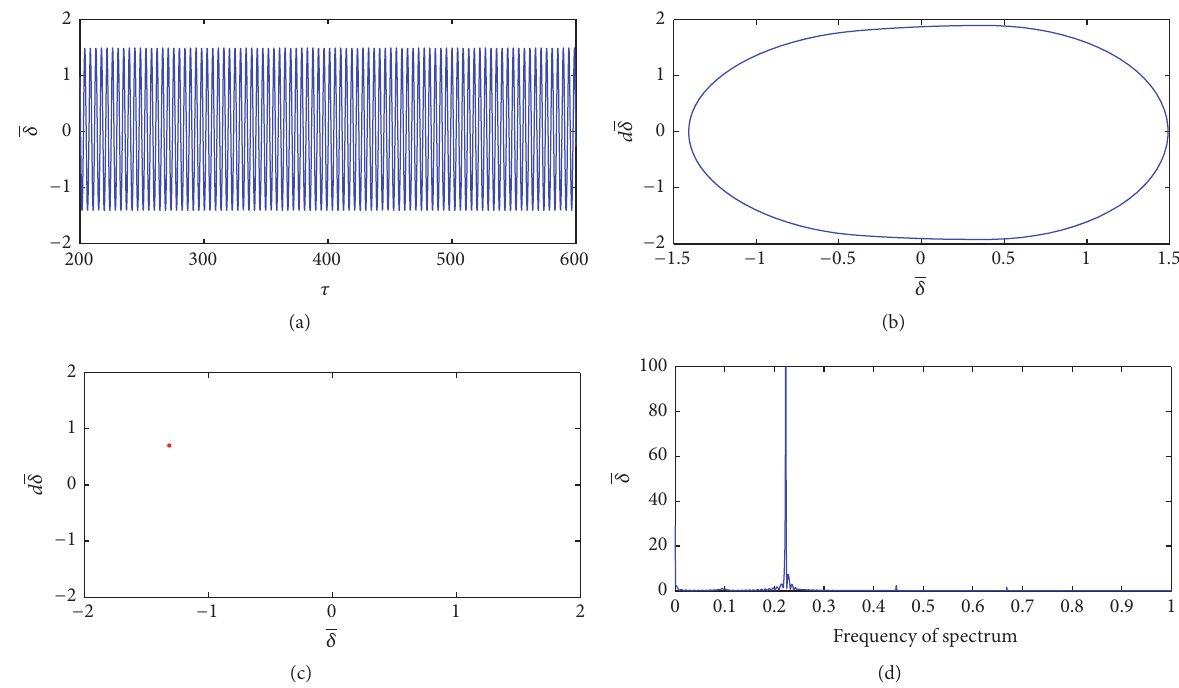
Figure 8: 𝜔 ℎ = 1.4 and 𝑓 = 1/3 : (a) time history; (b) phase plane; (c) Poincar´e map; (d) Fourier